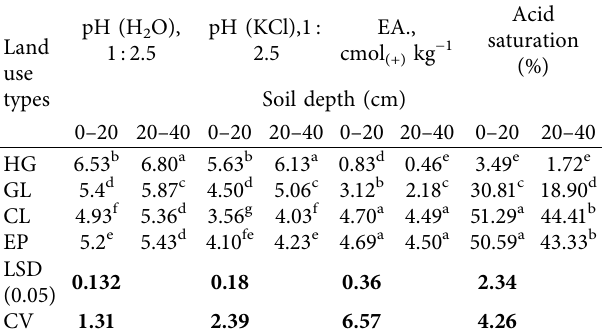
Table 2: Te interaction efects of land use and soil depth on soil pH (H 2 O), pH (KCl), Ex. acidity and acid saturation percentage of the soils in the Hojje watershed ( N �